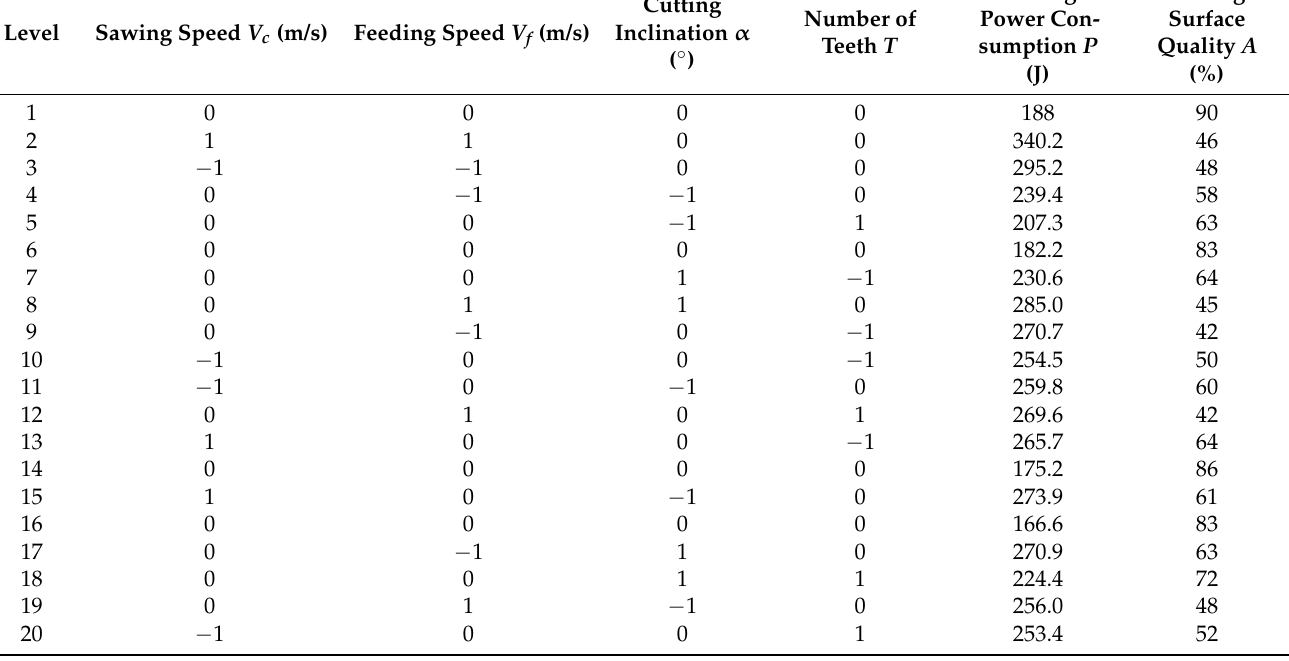
Table 3. Sawing test design scheme and response